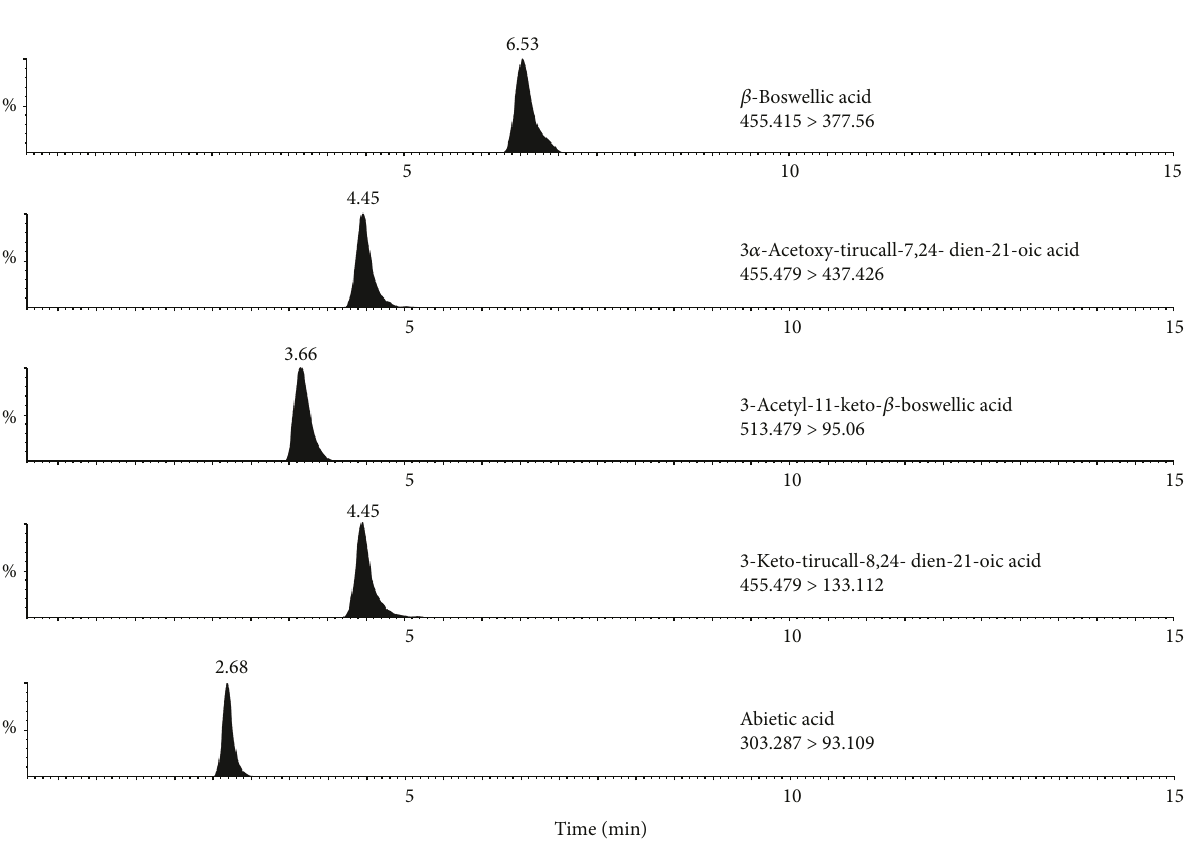
Figure 2: The UHPLC-TQ/MS method was adopted to qualitify the main bioactive components of WFM. By comparing the characterization of tR, λ max, and m/z with standard compounds, β -boswellic acid, 3 α -acetoxy-tirucall-7,24-dien-21-oic acid, 3-aectyl-11-keto- β -boswellic acid, 3-keto-tirucall-8,24-dien-21-oic acid, and abietic acid were used as the marker to identify the